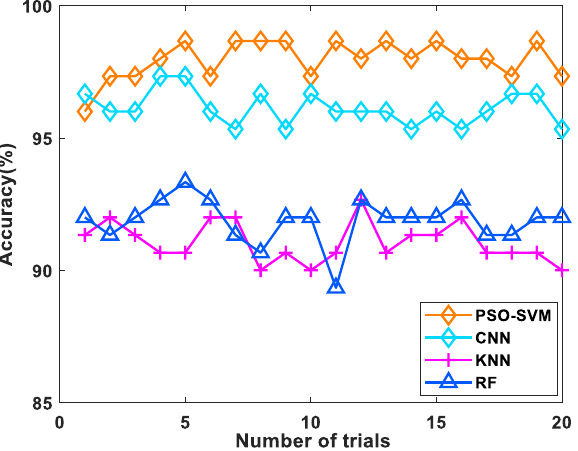
Figure 10. Comparison of classification accuracy with various algorithms. Table 6. Classification results under different